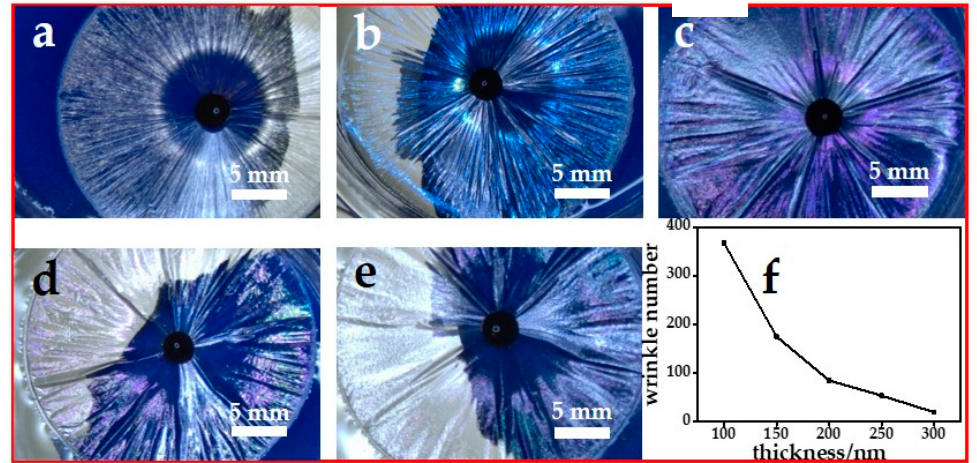
Figure 3. Optical microscopy images of surface morphologies of the floating PS film with ( a ) 100 nm, ( b ) 150 nm, ( c ) 200 nm, ( d ) 250 nm, ( e ) 300 nm thickness, when a 4 μ L magnetic droplet is dripped on the PS film and the magnet is 7.5 mm away from the magnetic droplet. ( f ) The relationship of the number of wrinkles to the film thickness.